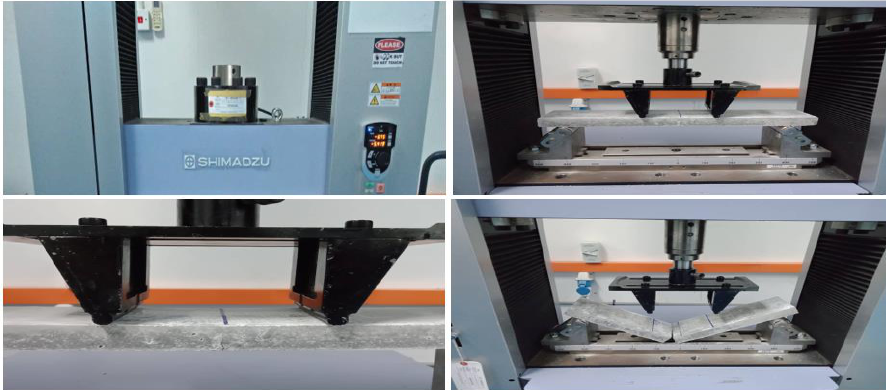
Figure 2. Third point loading procedure.